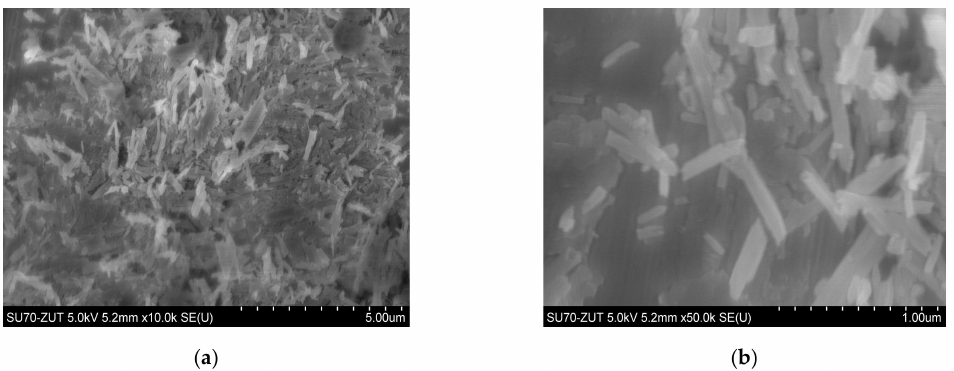
Figure 2. Morphology of halloysite nanotube with visible HNTs at di ff erent magnification ( a ) × 10 k, ( b ) × 50